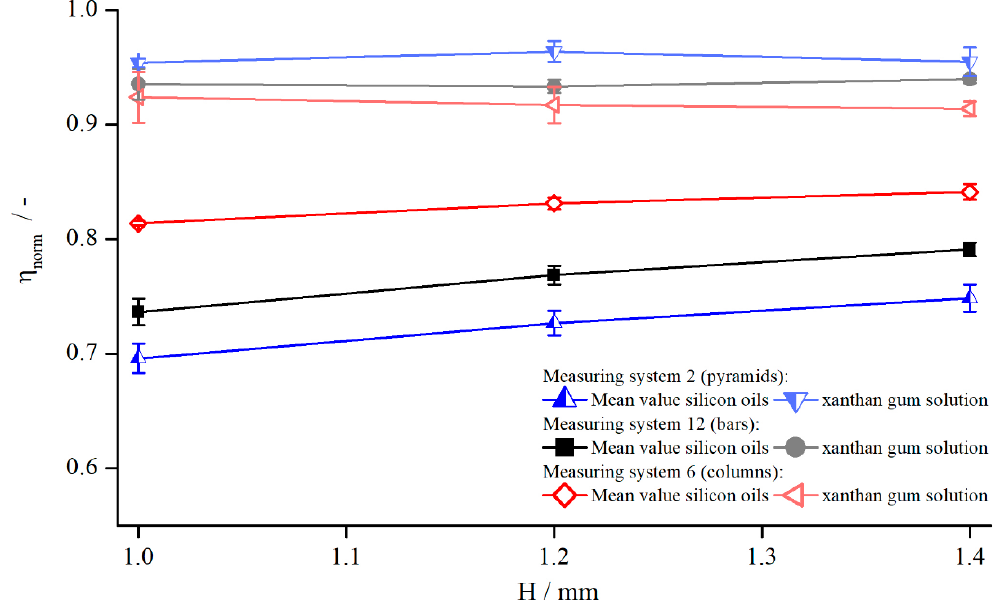
Figure 12. Comparison between normalised viscosities of xanthan gum solution and silicon oils dependent on gap height, measured with pyramids (system 2, L = 0.5 mm), columns (system 6, L = 0.5 mm), and bars (system 12, L = 0.3 mm ) at 𝛾(cid:4662) = 5.05 1/s .